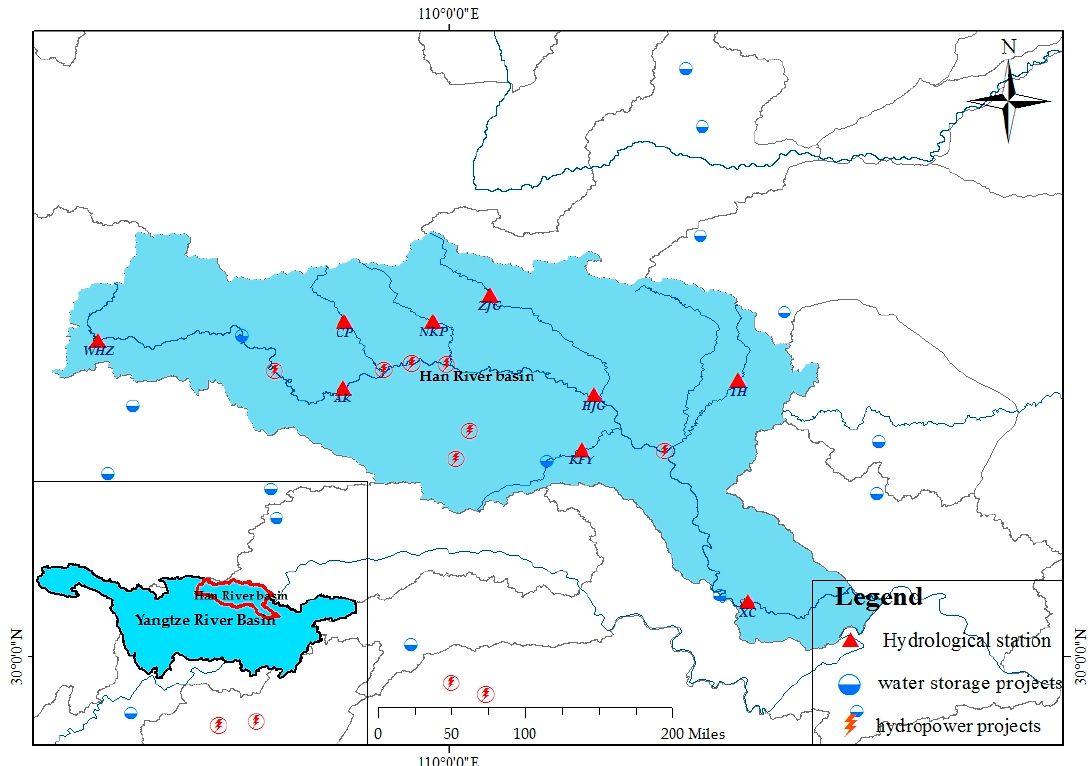
Figure 2. Delivery of water storage and hydropower projects, and typical hydrological stations in the Han River basin.